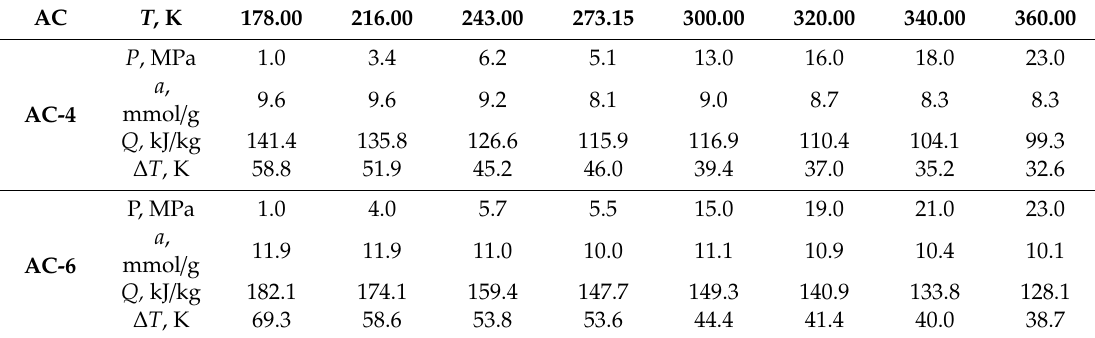
Table 3. Thermodynamic characteristics of the adsorbed natural gas (ANG) systems based on AC-4 and